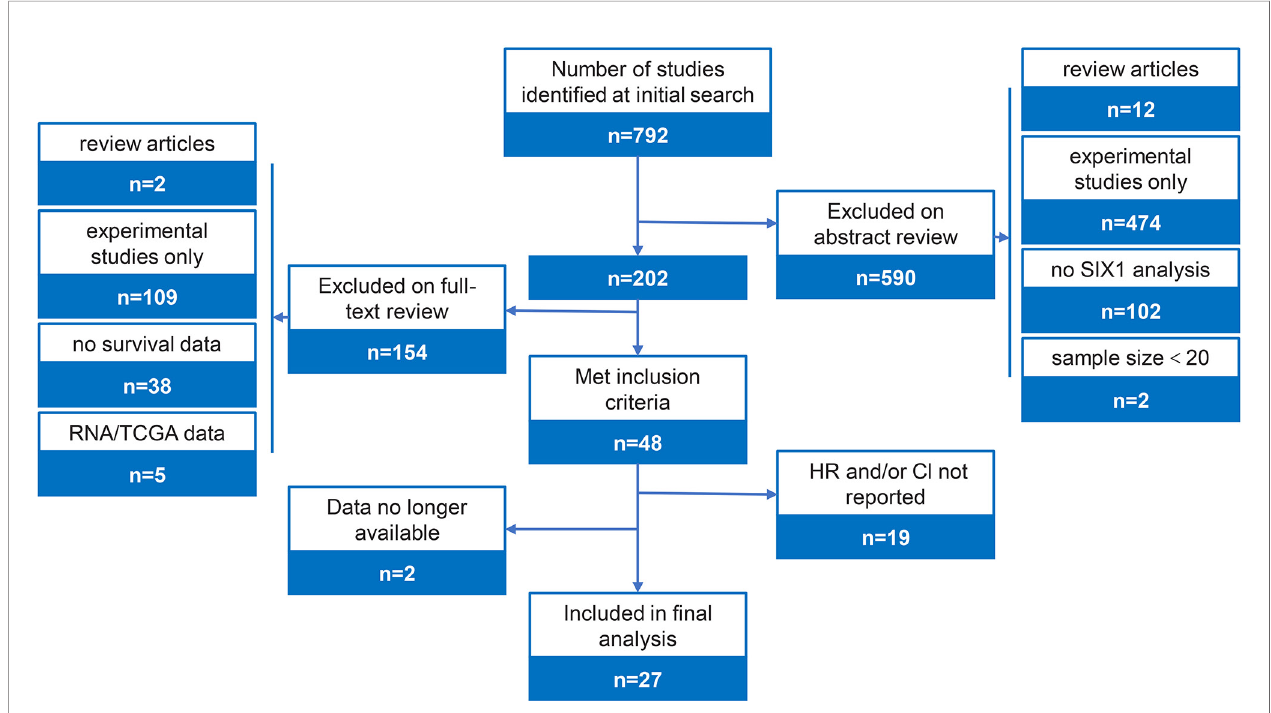
FIGURE 1 | Study fl ow diagram and selection